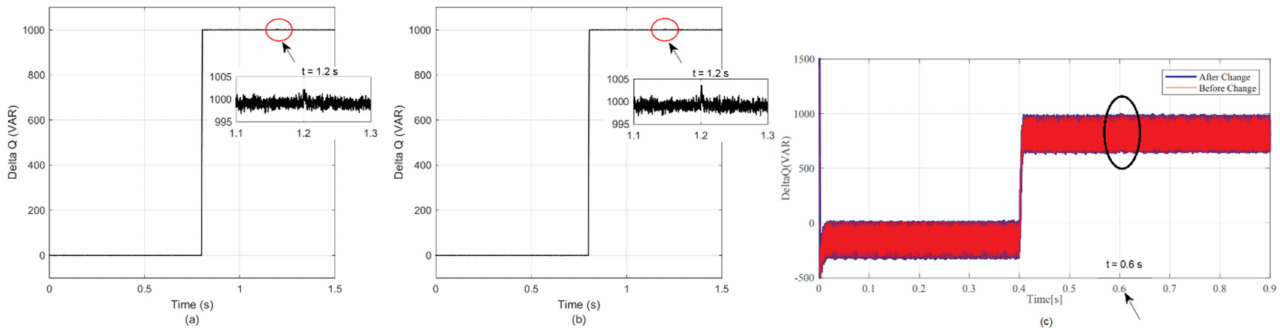
Figure 7. Variation of reactive power of AC-MG compensated by inverter 2, ( a ) with the first set of MG parameters, ( b ) with the second set of MG parameters, and ( c ) with two different sets of hybrid MG parameters in reference